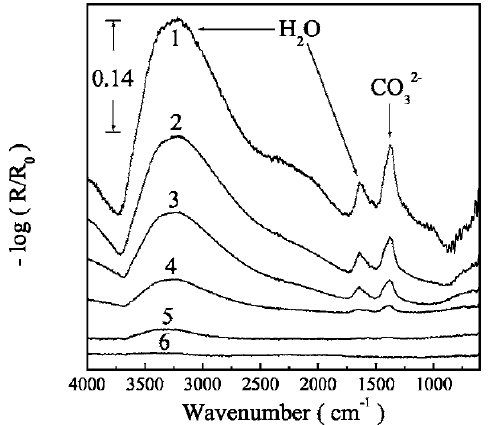
Figure 6. Infrared (IR) microscopy spectra taken at (1) − 50; (2) − 10; (3) 20; (4) 50; (5) 100; (6) 200 μ m from the edge of the droplet [66]. A NaCl particle was deposited on the copper sample and it was exposed for 3 h to 350 ppm CO 2 (g) and 80% RH. Negative values indicate that the spots are within the droplet. Reproduced from reference [66] by permission of The Electrochemical Society. Copyright 2005.